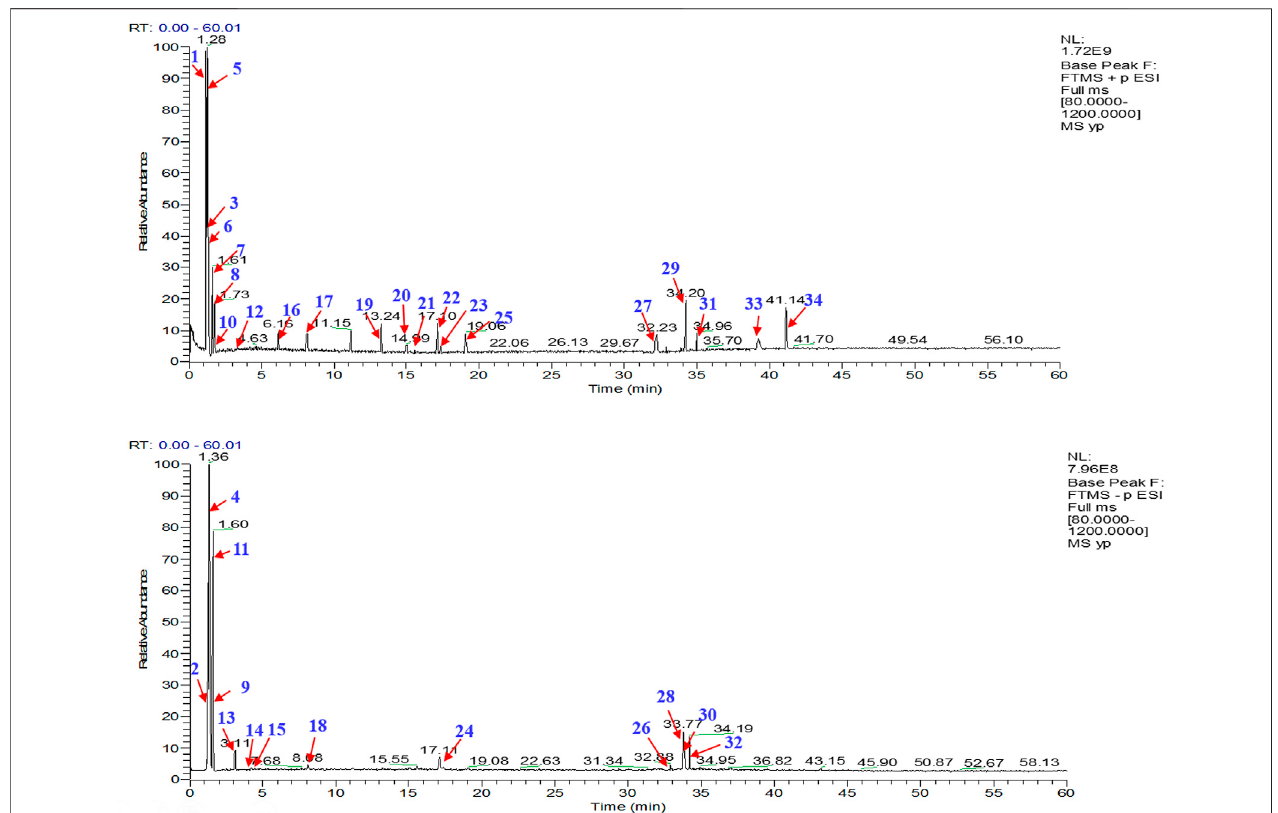
FIGURE 2 | Total ion current diagram of BTP with positive (upper) and negative modes (lower)